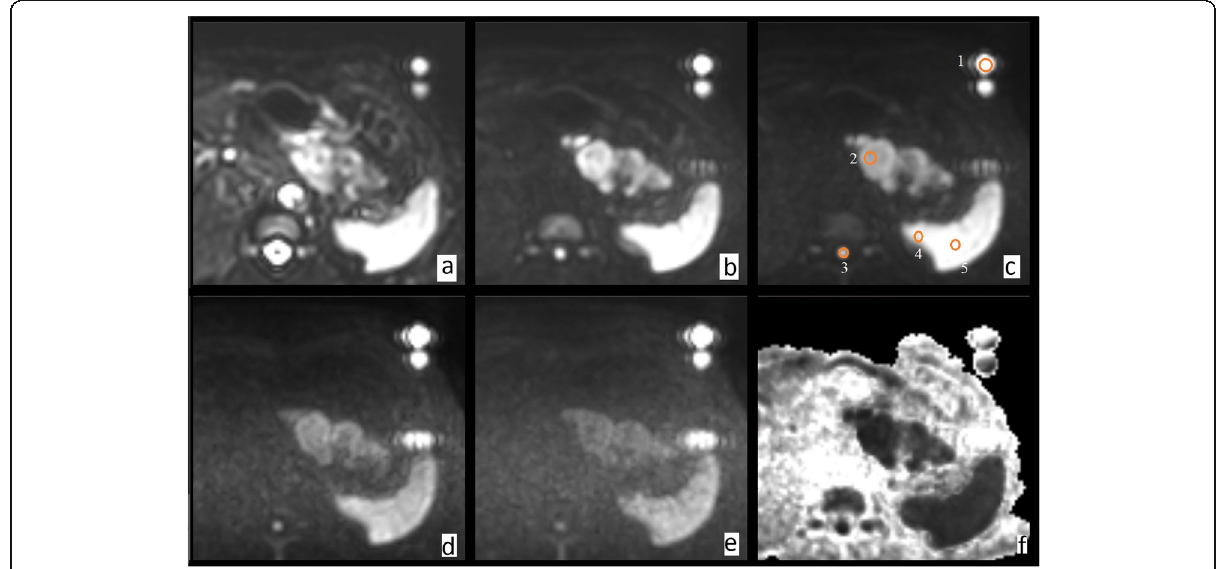
Fig. 7 The in vivo DWI with b -factor of ( a ) 0 s/mm 2 , ( b ) 500 s/mm 2 , ( c ) 1000 s/mm 2 , ( d ) 2000 s/mm 2 , ( e ) 3000 s/mm 2 , and ( f ) exponential image